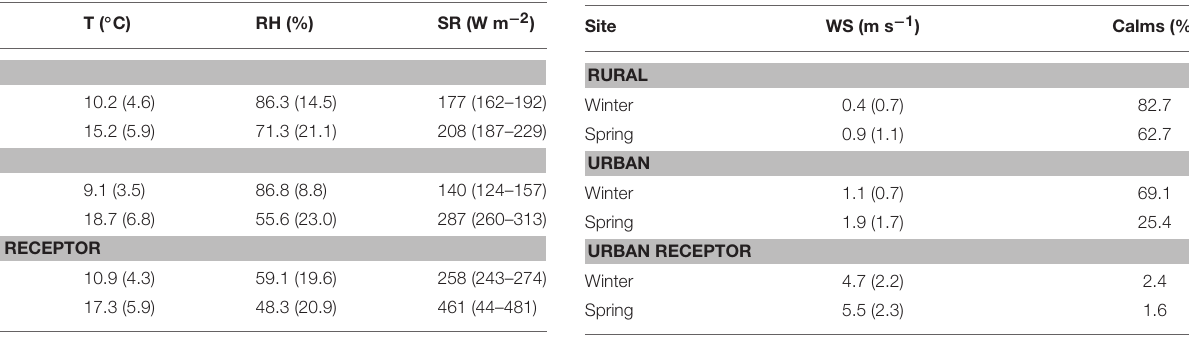
TABLE 2 | Temperature (T), relative humidity (RH), solar radiation* (SR) during the sampling